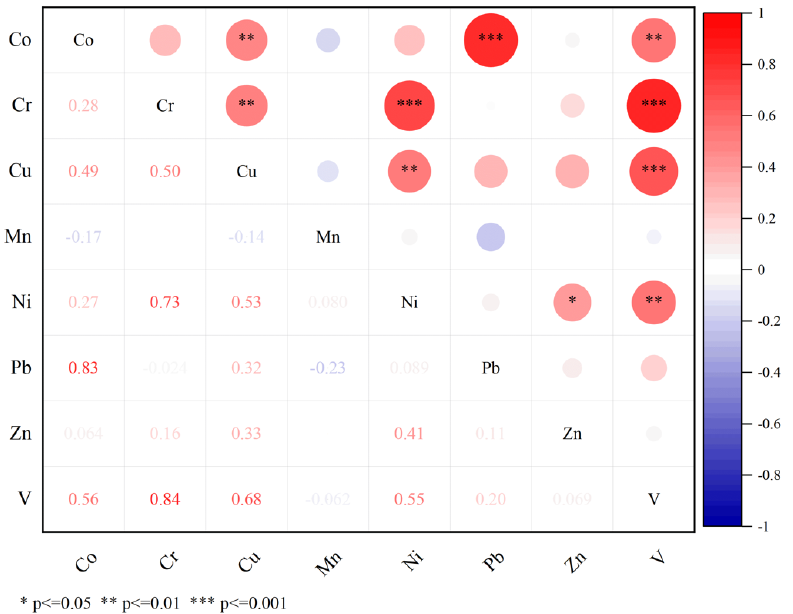
Figure 6. Correlation analysis of potentially toxic elements in soil in the study area. * represents the probability significance level 0.05, ** probability significance level 0.01, and *** represents the probability significance level 0.001.